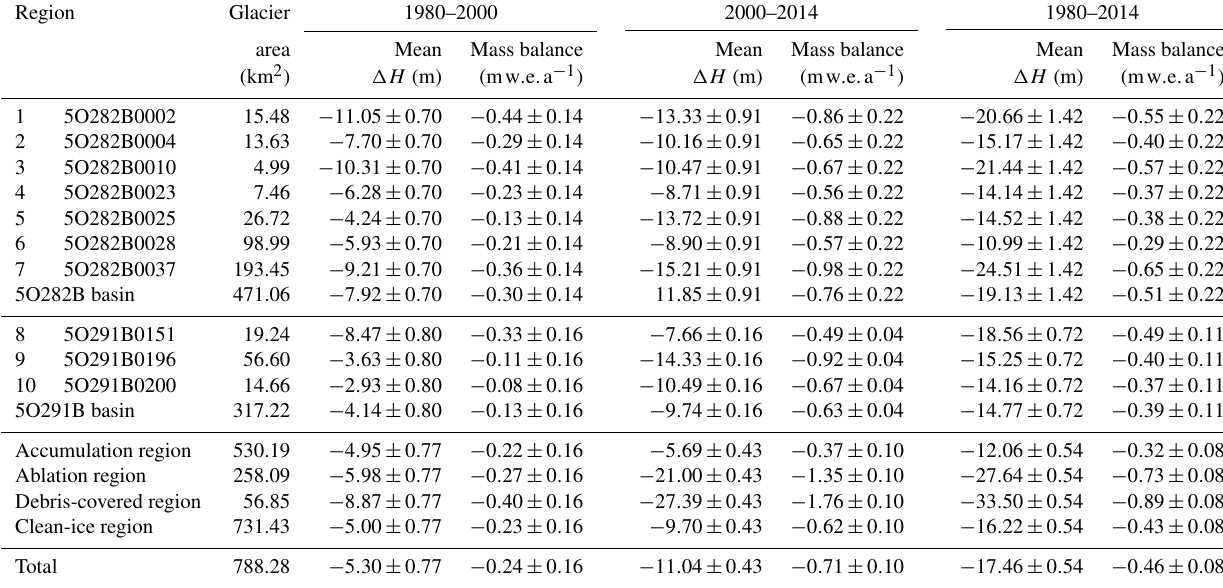
Table 7. Mean surface elevation changes and mass balance for the single glaciers and different regions in the Kangri Karpo from 1980 to 2014. Glacier area is the geometric union of the 1980, 2000s and 2015 glacier areas. Mean (cid:49)H is mean surface elevation change and mass balance is the annual mass